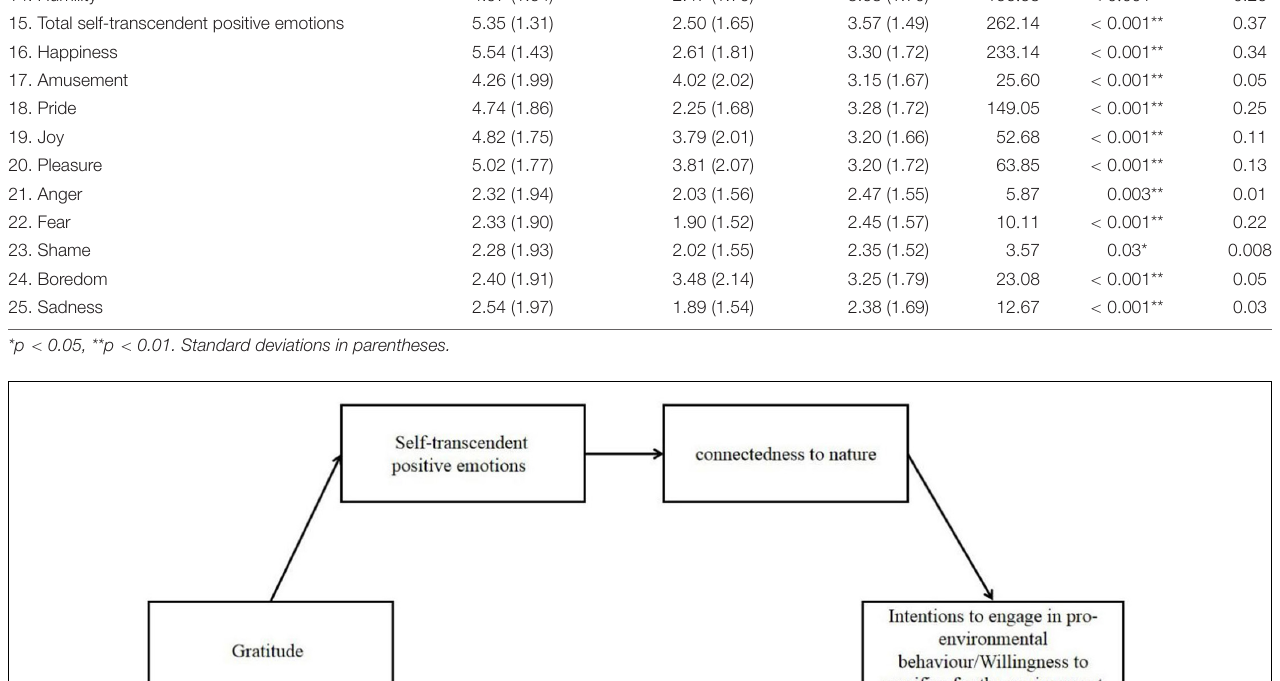
gratitude group had higher scores for self-transcendent positive emotions, and there was also a significant difference between the recreation and control groups ( p = 0.003, d =